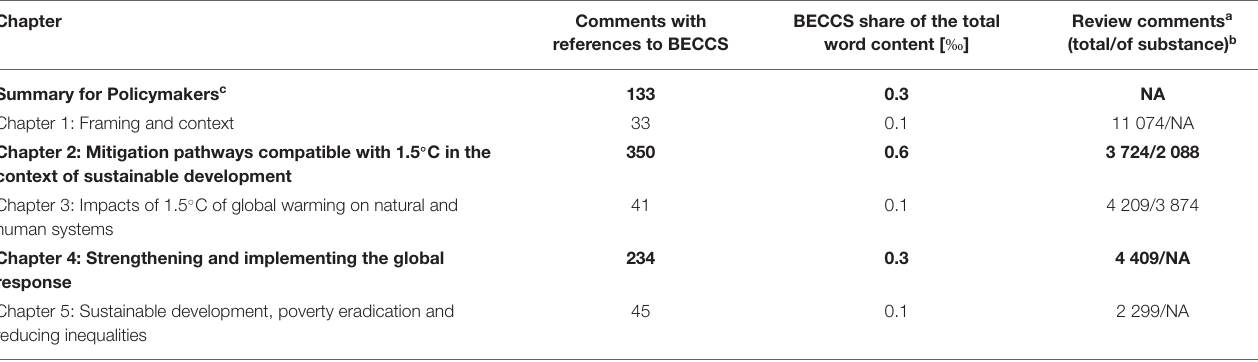
TABLE 1 | The share of the acronym BECCS of the total content of the review comments and responses to the first order draft of the Summary for Policymakers and individual chapters of the second order draft of the full report.